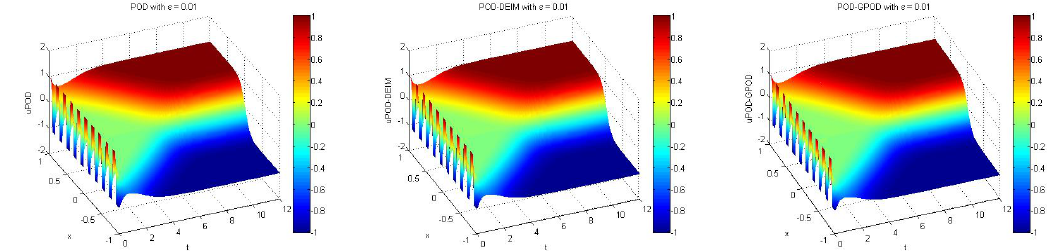
Figure 2. [Test 1] Solution of the POD, POD-DEIM, and POD-GPOD reduced systems with (cid:101) = 0.01 (from left to